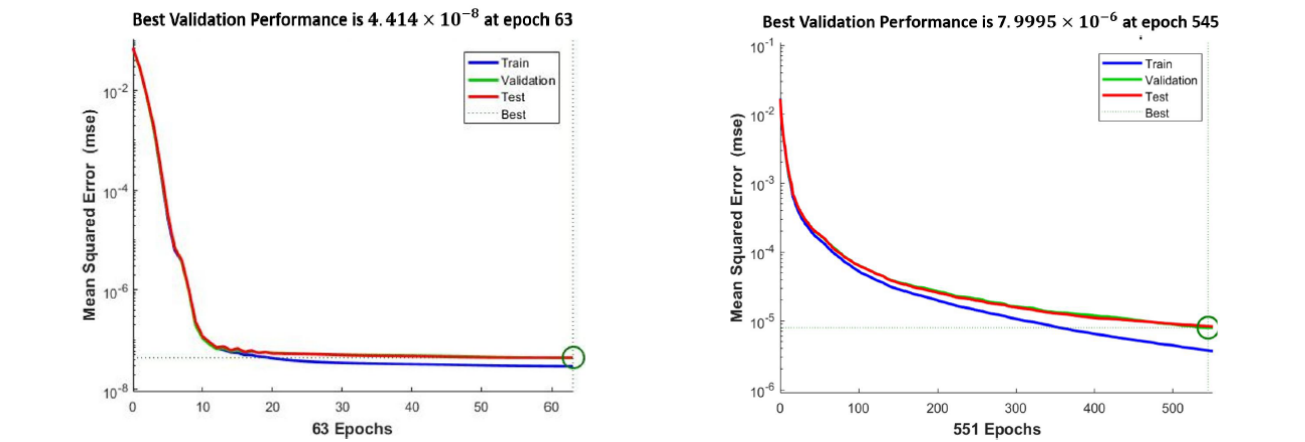
Figure 12. Performance of